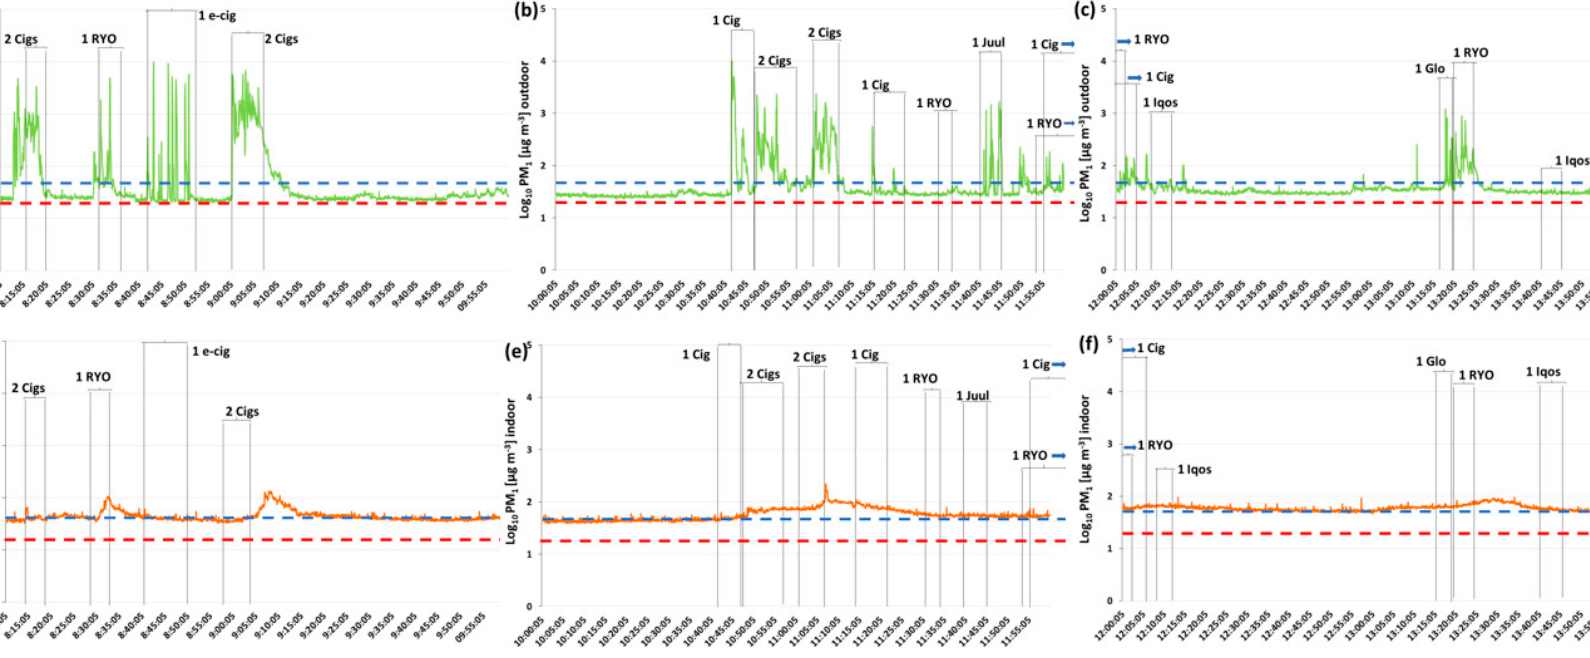
Figure 3. Levels of PM 1 (µg m − 3 ), expressed in Log (10) PM 1 , measured, respectively, outdoors ( a, b, c ) and indoors ( d, e, f ) during the morning measuring session. 1. cig = one conventional cigarette; RYO = “Rolled your own” hand-rolled cigarette; e-cig = electronic cigarette. Red dropped line: WHO guideline value for PM 2.5 (24-h mean). Blue dropped line: WHO guideline value for PM 10 (24-h mean).